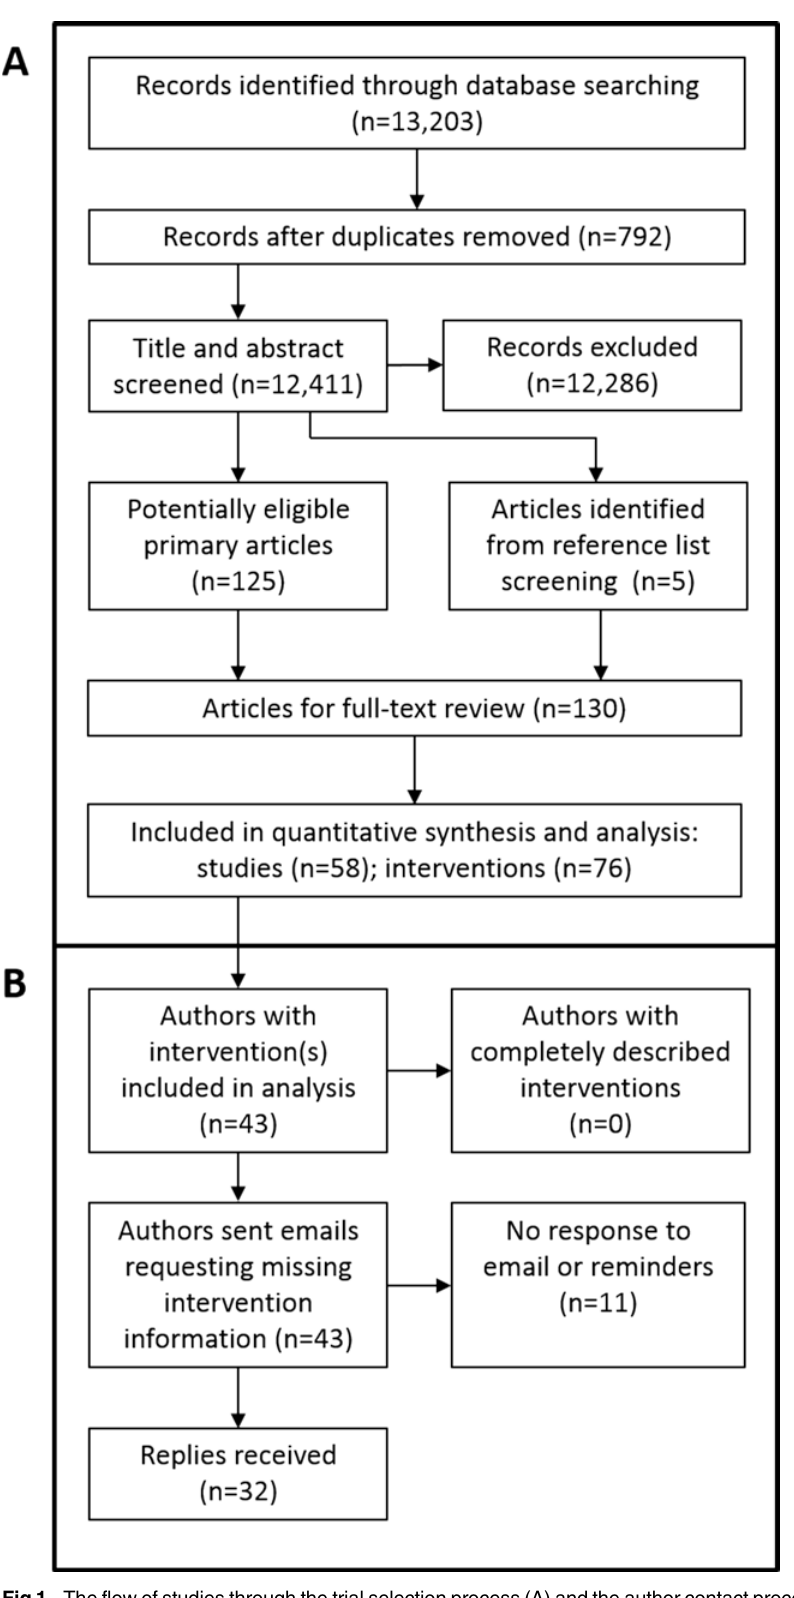
Fig 1. The flow of studies through the trial selection process (A) and the author contact process (B).